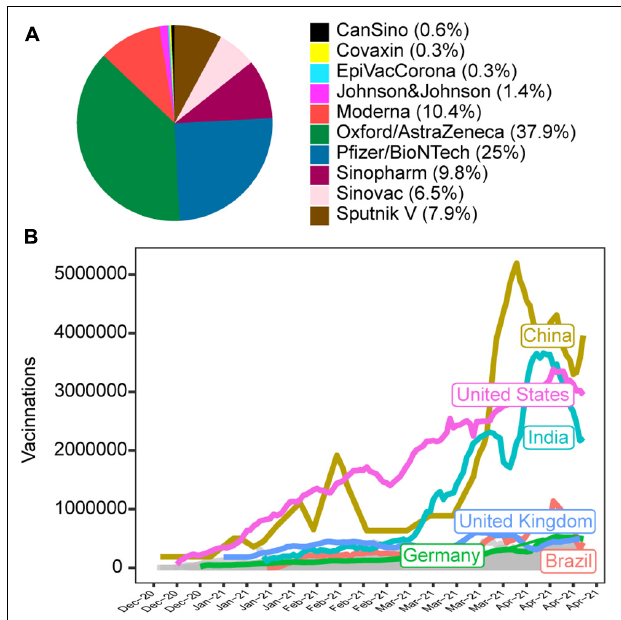
FIGURE 1 | Worldwide distribution of vaccines. (A) Proportional of usage of vaccines by countries represented in a sector graph. (B) Daily distribution in all countries with a top six countries highlighted.